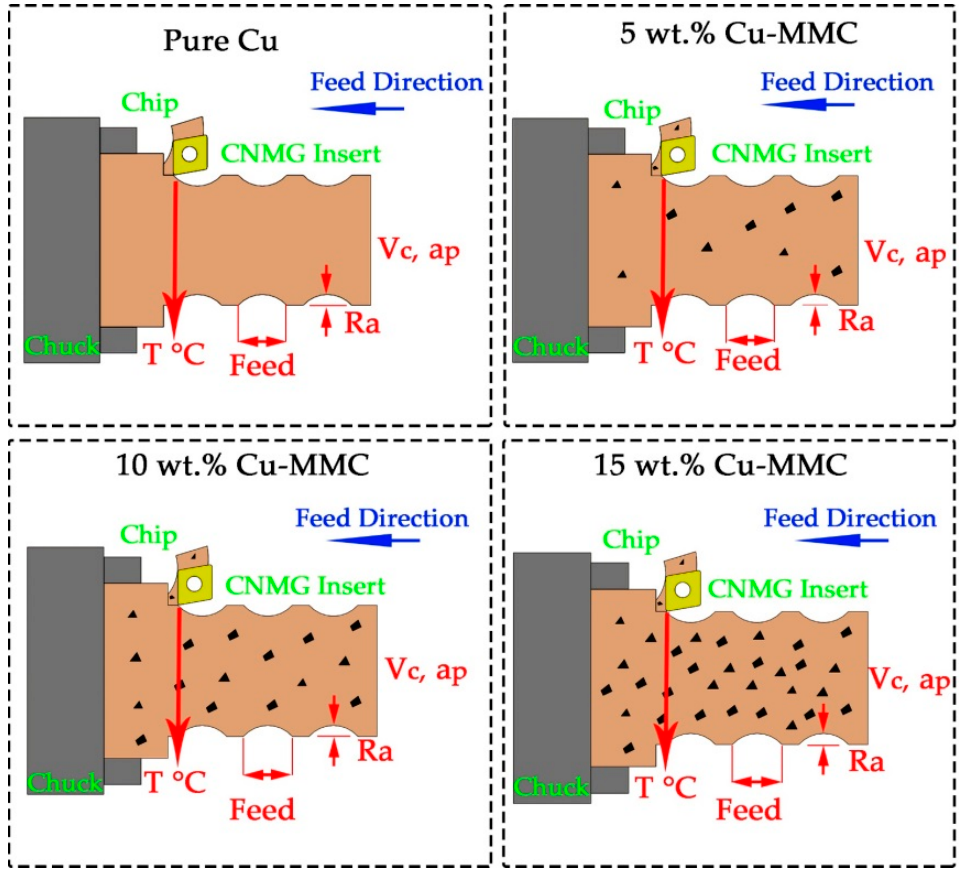
Figure 2. A schematic view of turning of composites.